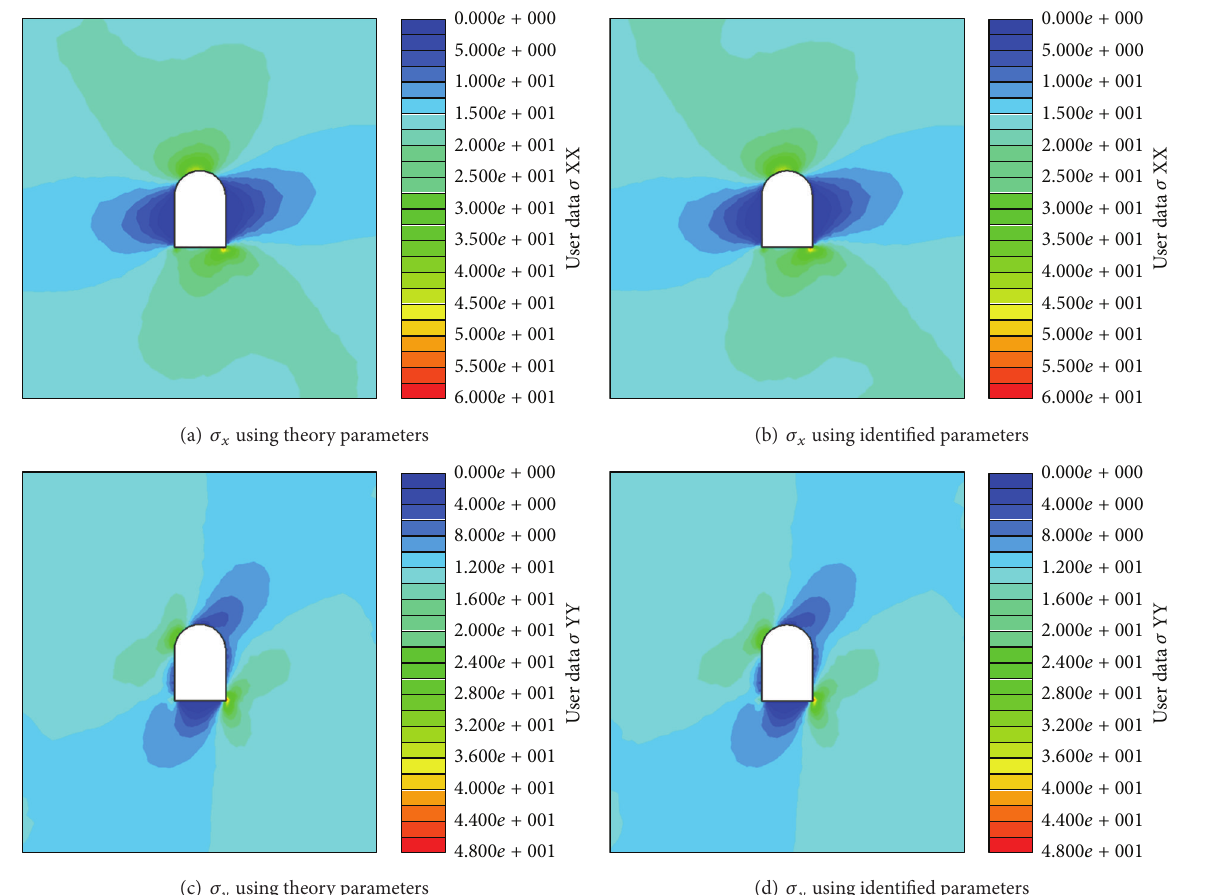
Figure 12: Calculated stress comparison between using theory value and identified value at stage